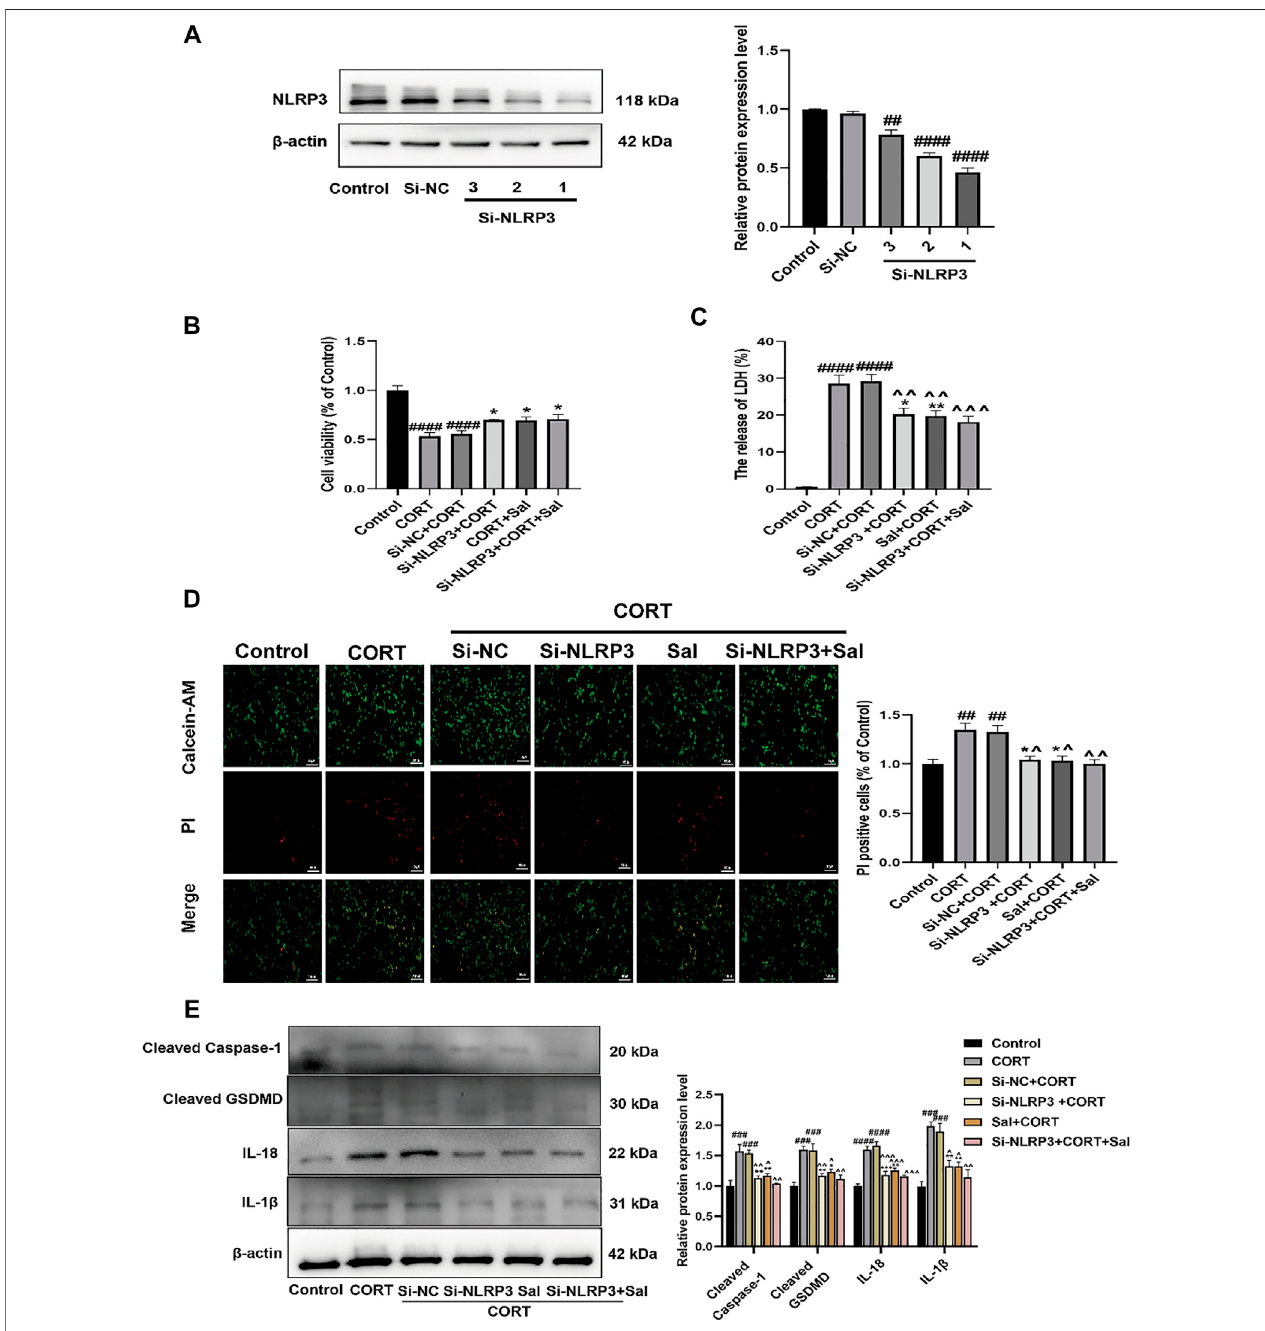
FIGURE 9 | Sal and knockdown of NLRP3 attenuates CORT-induced pyroptosis in PC12 cells. (A) NLRP3 was knocked down by NLRP3 siRNA in PC12 cells, transfectionef fi ciencyofNLRP3wasdetectedbywesternblot( n =3). (B) TheviabilityofcellswasdetectedbyCCK-8assay( n =6). (C) CellcytotoxicityinPC12cellswas detected by LDH cytotoxicity assay ( n = 6). (D) Cell viability and cytotoxicity were measured by Calcein-AM/PI staining. Calcein-AM (in green), PI (in red). Original magni fi cation: ×200, Scale bar = 100 μ m, n = 3. (E) The levels of cleaved caspase-1, IL-1 β , IL-18, and cleaved GSDMD in PC12 cells were assessed by western blot analysis ( n = 3). #### p < 0.0001, ### p < 0.001, ## p < 0.01 compared with the control group; ** p < 0.01, * p < 0.05 compared with the CORT group; ^^^^ p < 0.0001, ^^^ p < 0.001, ^^ p < 0.01, ^ p < 0.05 compared with Si-NC + CORT group.